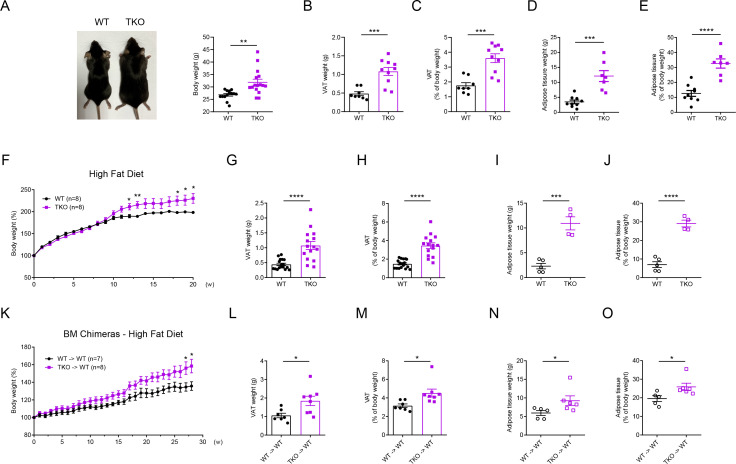
miR-17~92 family miRNAs protect mice from obesity.(A) A representative photograph (left panel) and body weight (right panel) of the Lyz2-Cre (WT) and miR-106a~363−/− miR-106b~25−/− miR-17~92flox/flox
Lyz2-Cre (TKO) mice at the age of 30 weeks, n = 14–16 per group. (B and C) Visceral adipose tissue (VAT) weight (B) and VAT percentage of body weight (C) of WT and TKO mice at the age of 30 weeks. (D and E) Total adipose tissue weight (D) and its percentage of body weight (E) of WT and TKO mice were measured by scanning the whole mice with magnetic resonance imaging (MRI) machine at the age of 30 weeks. (F–J) WT and TKO mice were fed with a high-fat diet (HFD) and were sacrificed on 13–20 weeks post HFD. Body weight of each mouse was measured weekly, n = 8 per group (F); VAT weight (G), VAT percentage of body weight (H), total adipose tissue weight (I), and its percentage of body weight (J) were measured. (K–O) C57BL/6J mice were irradiated and transferred with WT (WT → WT) or TKO (TKO → WT) bone marrows (BMs). Then these BM chimeras were fed with an HFD and were sacrificed on 16–28 weeks post HFD. Body weight of each mouse was measured weekly, n = 7–8 per group (K); VAT weight (L), VAT percentage of body weight (M), total adipose tissue weight (N), and its percentage of body weight (O) were measured. *p<0.05, **p<0.01, ***p<0.001, and ****p<0.0001 (unpaired Student’s t-test). Data are pooled from four (A–C), two (D, E, F, K, L, and M), or five (G and H) independent experiments (mean ± s.e.m.), or are representative of one independent experiment (I, J, N, and O).